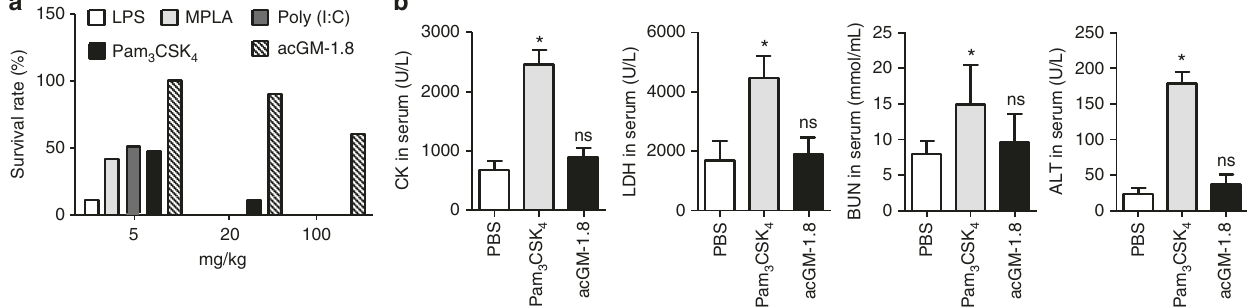
Fig. 7 Assessment of the safety of acGM-1.8 in vivo. a acGM-1.8, or four classical TLR ligands: LPS, MPLA, Poly (I:C) and Pam 3 CSK 4 , was intraperitoneally injected to mice at the same dose. The survival rate was calculated after 24 h of injection; n = 10. b Measurement of the key biochemical parameters, including creatine kinase (CK), lactic dehydrogenase (LDH), blood urea nitrogen (BUN), and alanine transaminase (ALT), in the serum of the mice alive after injected with PBS, Pam 3 CSK 4 , or acGM-1.8 (20 mg/Kg); * P < 0.05 versus the PBS treatment; n =